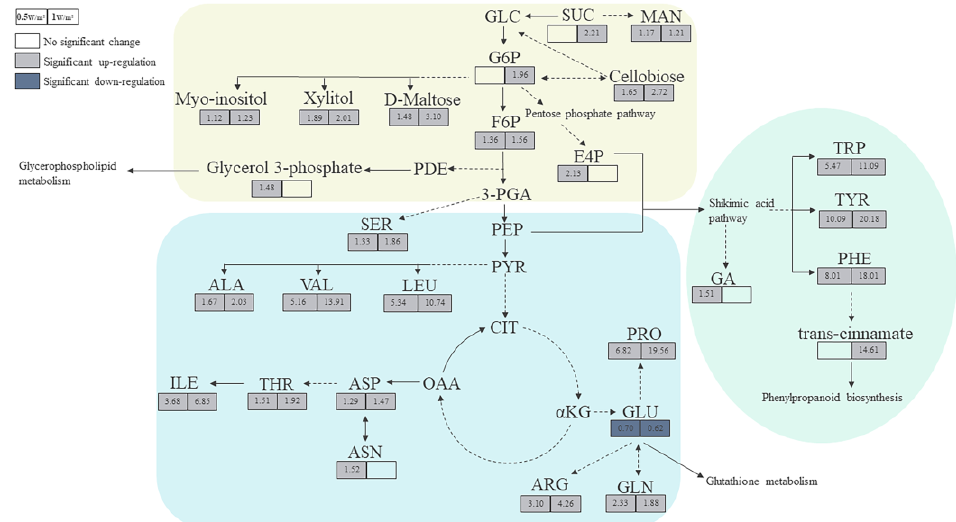
Figure 6. Metabolic pathway of Porphyra haitanensis under different UV-B radiation intensities. The values in the box represent the fold change of the metabolites; a multiple > 1 indicates upregulation, while a multiple < 1 indicates downregulation. The black solid and dotted arrows indicate direct and indirect reactions, respectively. MAN, D-mannose; SUC, sucrose; GLC, glucose; G6P, D-glucose 6-phosphate; F6P, beta-D-fructose-6-phosphate; PDE, dihydroxyacetone phosphate; 3-PGA, glycerate-3-phosphate; SER, DL-serine; PEP, phosphoenolpyruvic acid; E4P, D-erythrose 4-phosphate; GA, gallic acid; PHE, L-phenylalanine; TYR, L-tyrosine; TRP, L-tryptophan; PYR, pyruvic acid; ALA, L-alanine; VAL, L-valine; LEU, L-leucine; CIT, citric acid; OAA, oxaloacetic acid; ASP, L-aspartate; ASN, L-asparagine; THR, L-threonine; ILE, L-isoleucine; αKG, α-ketoglutarate; GLU, L-glutamate; GLN, L-glutamine; ARG, L-arginine; PRO, D-proline.